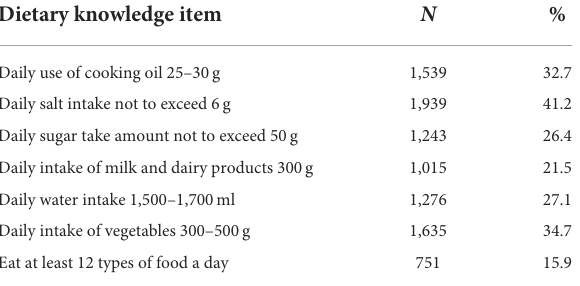
TABLE 2 Number of correct answers to each knowledge of adequate diets item ( N = 4,710).